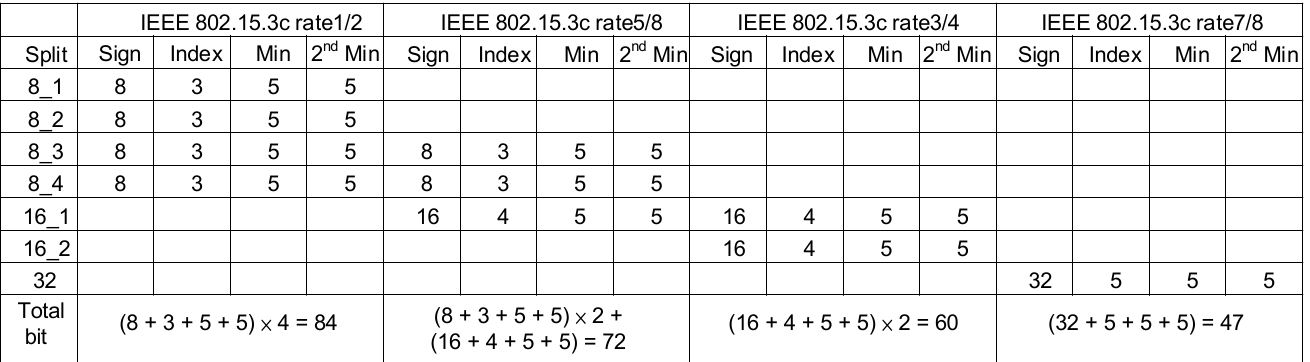
Figure 31. The number of bits required by the extrinsic memory in the IEEE 802.15.3c standard with different code rates.